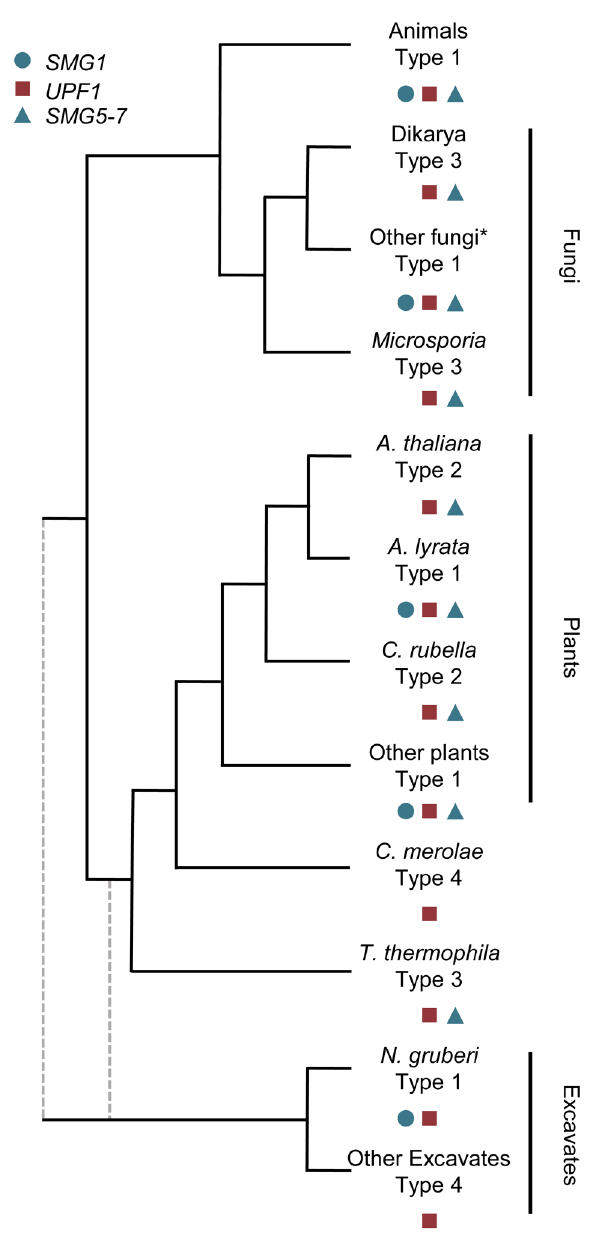
Figure 2. The various NMD types across diverse eukaryotic lineages. The distribution of the key NMD factors, UPF1, SMG1 and a member of the SMG5-7 family define the NMD pathway type. All NMD types have arisen multiple times within eukaryotic evolution. NMD pathways can be classified into four types, Type 1: classical SMG1 dependent NMD, Type 2: recent loss of SMG1 with S/TQ rich UPF1, Type 3: ancient loss of SMG1 with S/TQ depleted UPF1, Type 4: Heavily derived NMD (Figure 3). To date, no SMG5/6/7 family member has yet been identified in N. gruberi but given the presence of SMG1 45 , I am currently classifying it as a type 1 NMD pathway. The branch lengths do not reflect the relatedness of any species, but represent the order of separation between the lineages. The root of eukaryotes is unclear, so branches representing a Excavata early and late divergence are represent in grey, dashed- lines. *SMG1 appears to have been lost in other fungal lineages as well, representing repeated losses in multiple fungal lineages 45